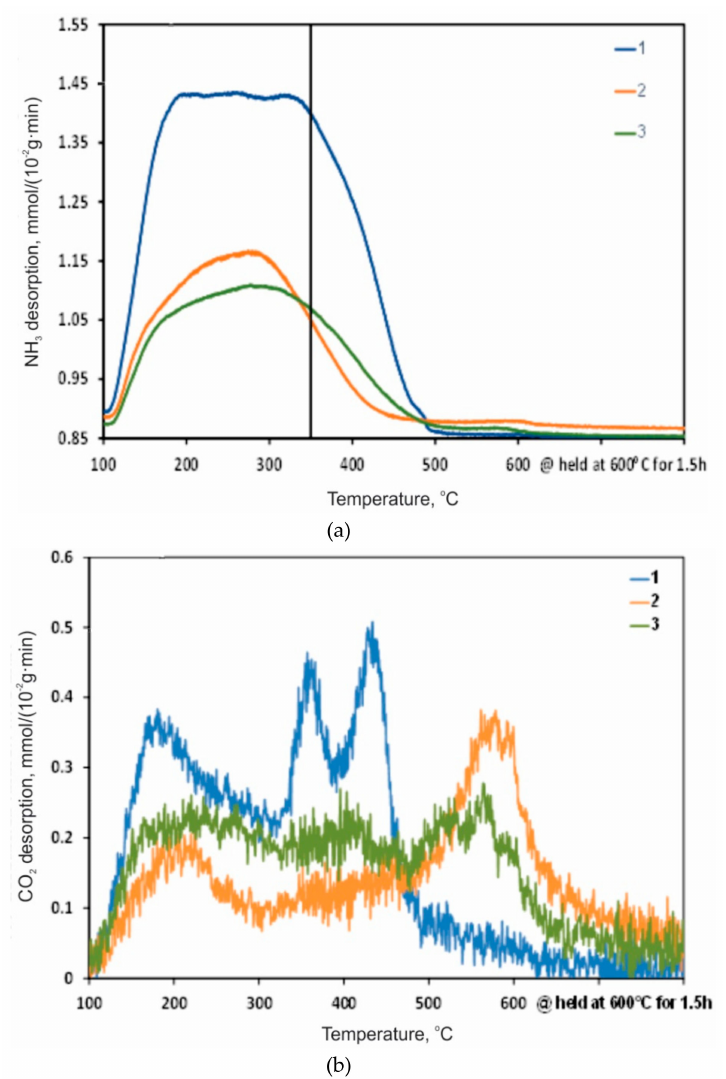
Figure 7. NH 3 - and CO 2 -TPD profiles recorded with TiO 2 materials used in the present study: